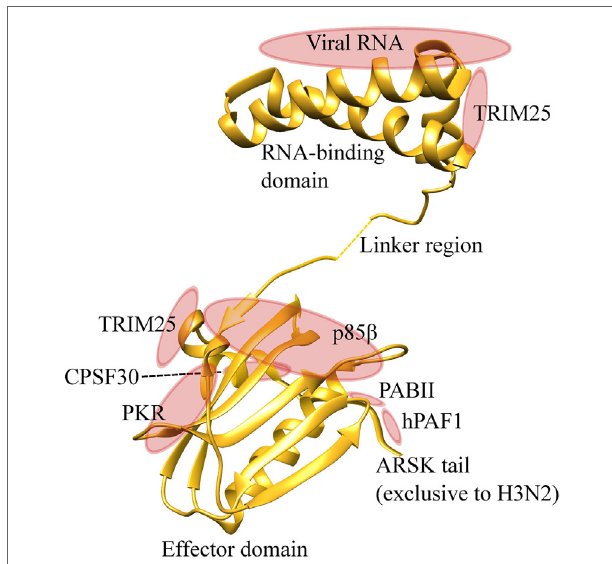
FigURe 4 | NS1 is an effective suppressor of host antiviral immunity. NS1 protein contains an amino-terminal RNA binding domain and carboxyl- terminal effector domain. RNA binding domain binds to viral RNAs and prevents detection by the host pattern recognition system. The effector domain binds to TRIM25, and inhibits RIG-I-MAVS interaction and downstream induction of type I and III IFNs. This domain also interacts with protein kinase R (PKR), therefore, inhibiting its pro-apoptotic activities. PI3K-p85 β subunit is also targeted by the effector domain to inhibit apoptosis. NS1 binds with CPSF30 and poly A binding protein II (PABII), inhibiting host protein synthesis and facilitating viral protein synthesis. The ARSK tail is exclusively found in H3N2, and directly binds with hPAF1 complex and inhibits the transcription of antiviral genes. Protein visualization was performed in UCSF chimera molecular visualization